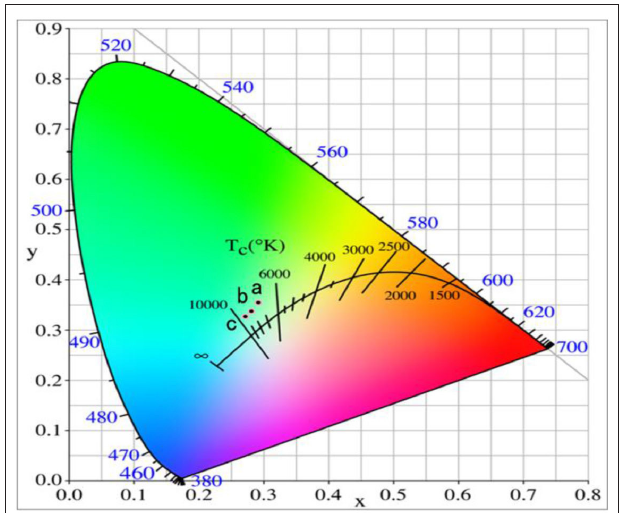
FIGURE 7 | Chromaticity coordinate of the GdAlO 3 : 0.6%Er 3 + , 16%Yb 3 + , 1%Tm 3 + phosphors prepared by calcining the precipitate at different